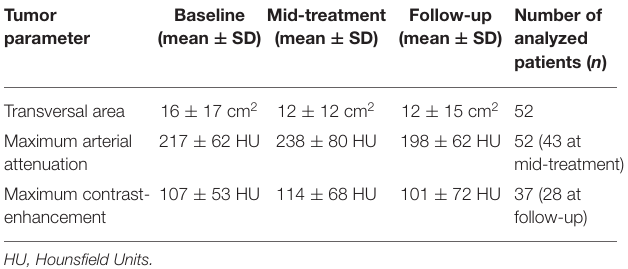
TABLE 1 | Tumor area, attenuation, and contrast-enhancement at baseline, mid-treatment, and follow-up. Tumor parameter